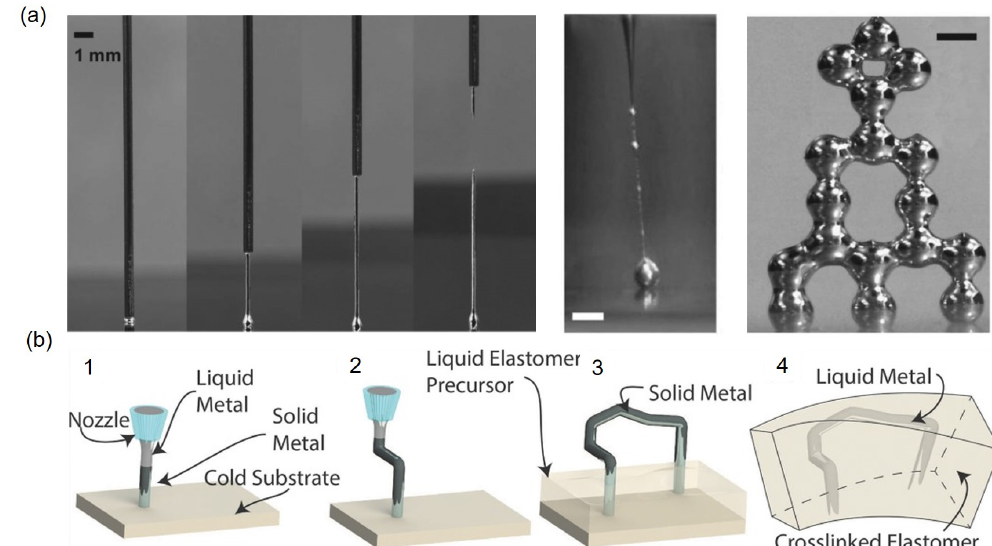
Figure 4. ( a ) Direct writing of a vertical liquid metal wire. Sequential images showing a syringe needle extrudes a liquid metal to form a straight wire by withdrawing the substrate. A tower of droplets made by 3D stacking liquid metal droplets. Scale bars represent 500 µm. Reproduced with permission from [52]; published by John Wiley and Sons, 2013. ( b ) Freezing liquid metals can form a 3D liquid metal structure that can be used as a master mold to make 3D channel. Reproduced with permission from [53]; published by John Wiley and Sons,